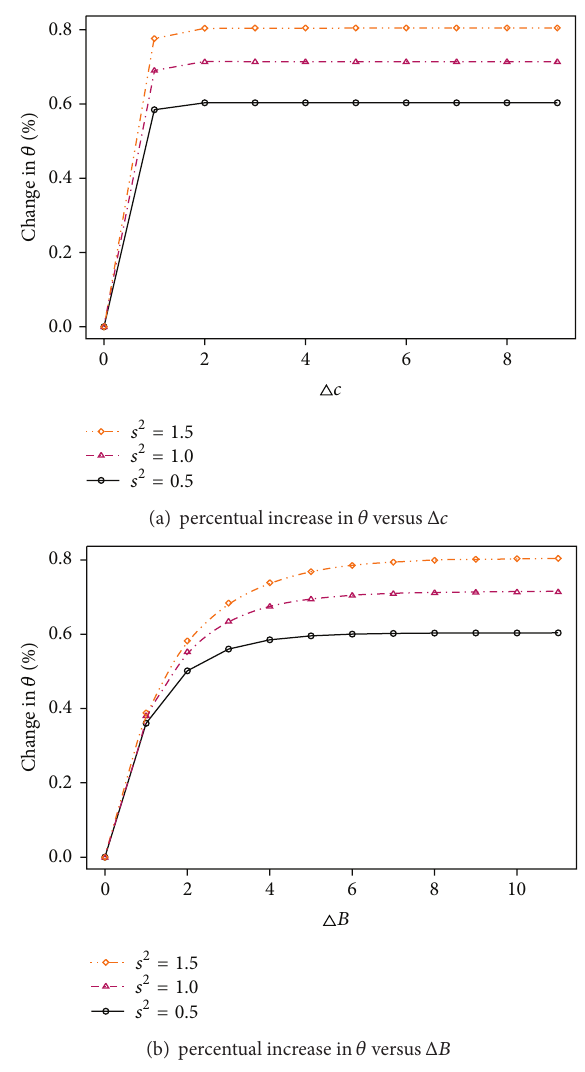
Figure 4: Throughput increase versus added number of servers ( Δ𝑐 ) and buffers ( Δ𝐵